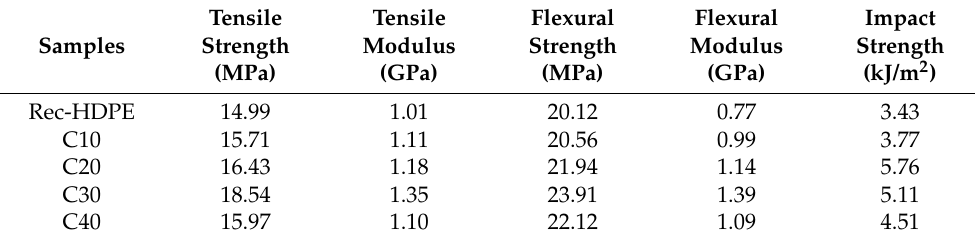
Table 3. Mechanical properties of the recycled HDPE and